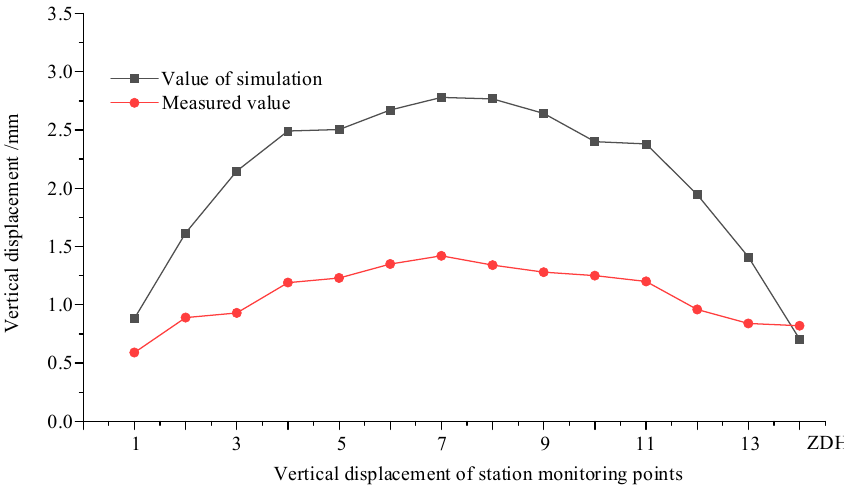
Figure 23. Comparison of simulation and actual measurement of vertical displacement at each monitoring point of the station.